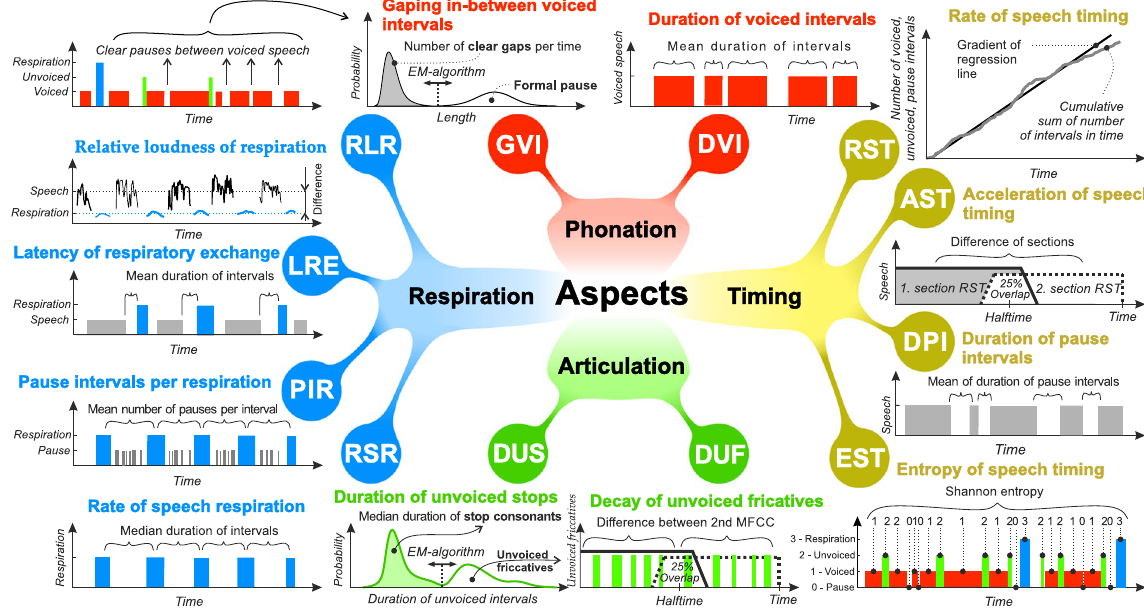
Figure 2. Mind map illustrating basic principles of individual acoustic speech features. MFCC = Mel-frequency cepstral